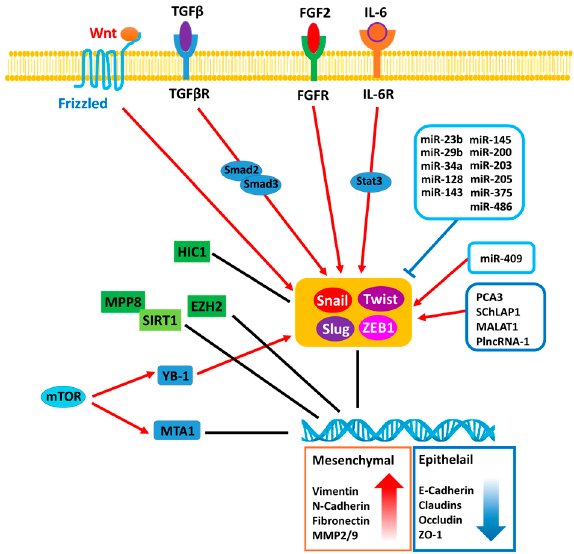
Figure 1. The regulatory mechanisms associated with epithelial-to-mesenchymal transition (EMT) in prostate cancer (PCa). MPP8: M-phase phosphoprotein 8; SIRT1: NAD-dependent deacetylase